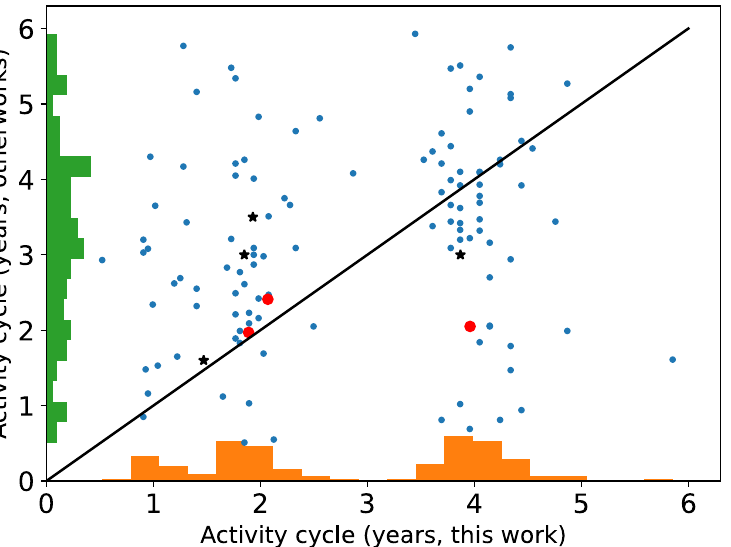
Figure 18. Magnetic activity periods compared for candidate stars detected in this work with stars which have previously been detected by other works. The periods of our commonly detected candidate stars are compared with the results of Reinhold et al. [29] (114 small blue dots), Montet et al. [27] (4 star-like dots), and Han et al. [60] (3 large red dots). Histograms of the periods from this work are along the x -axis, and those from Reinhold et al. [29] are along the y -axis. The line marks the one-to-one relationship between activity